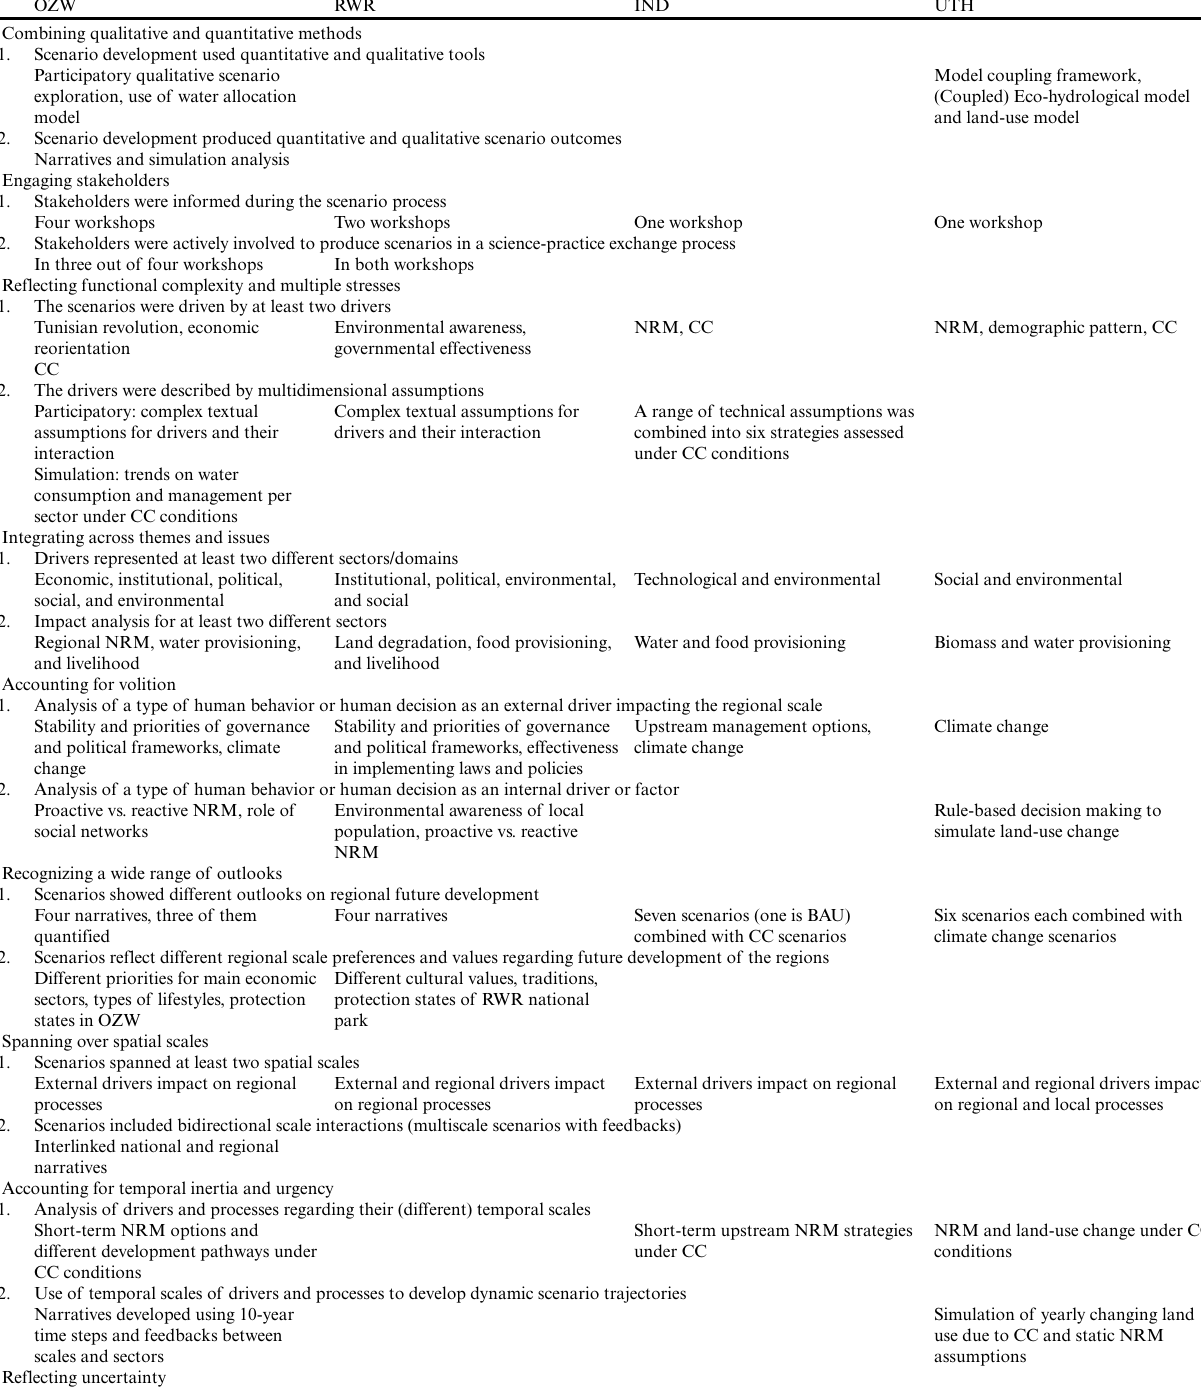
Table 2 . Main findings regarding the implementation of the nine research challenges in the four case studies. CC = climate change, NRM = Natural Resources Management, OZW = Oum Zessar watershed, RWR = Rwenzori region, IND = Inner Niger Delta, UTH = upper Thukela / uThukela basin. OZW RWR IND